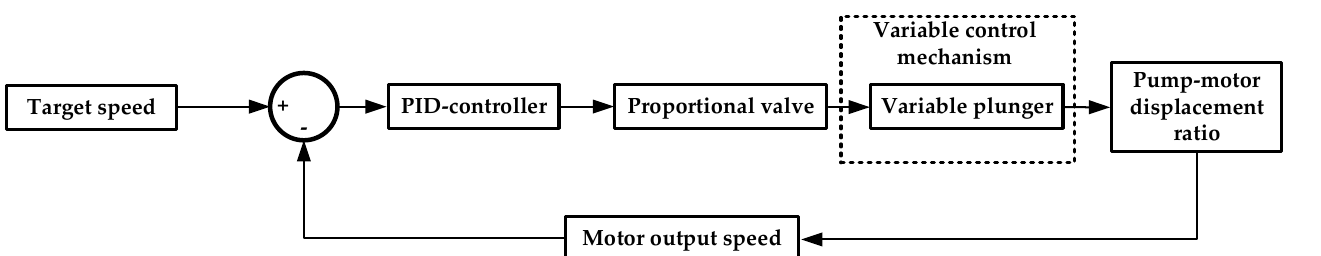
Figure 4. Schematic diagram of the output speed closed-loop PID control of the pump-motor system.